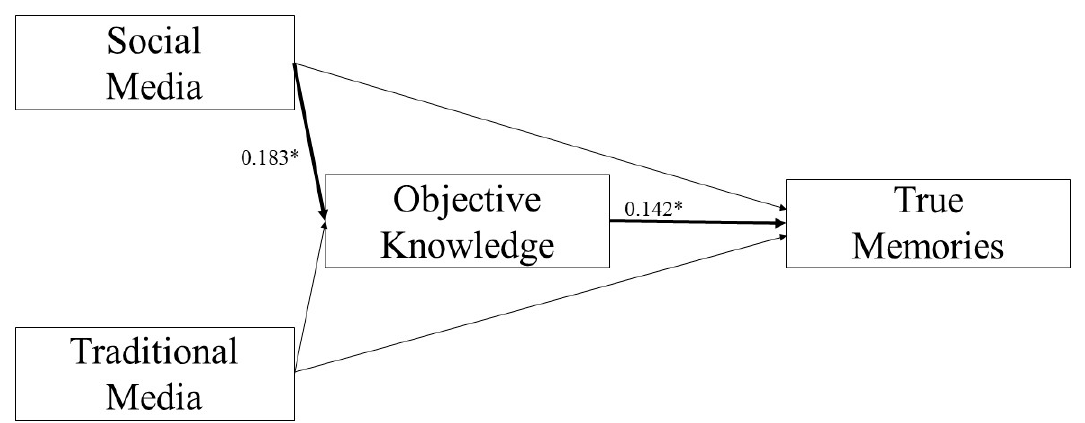
Figure 1. Scheme of the mediation effect of objective knowledge in the relationship between social media and true memories (* p <